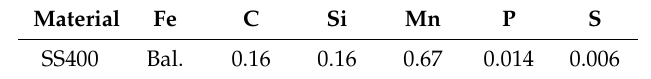
Table 1. Chemical composition of steel SS400 (wt %).